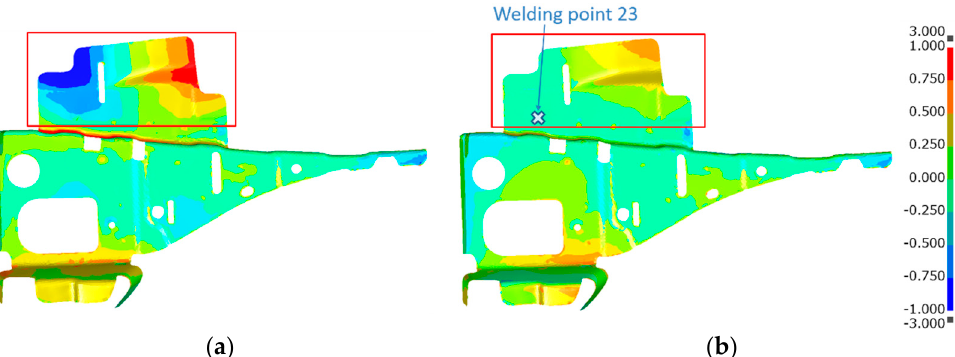
Figure 21. Comparison of measured and predicted geometry of the upper part. ( a ) Initial nugget mesh without update; ( b ) Nugget mesh at the weld 23 with update.